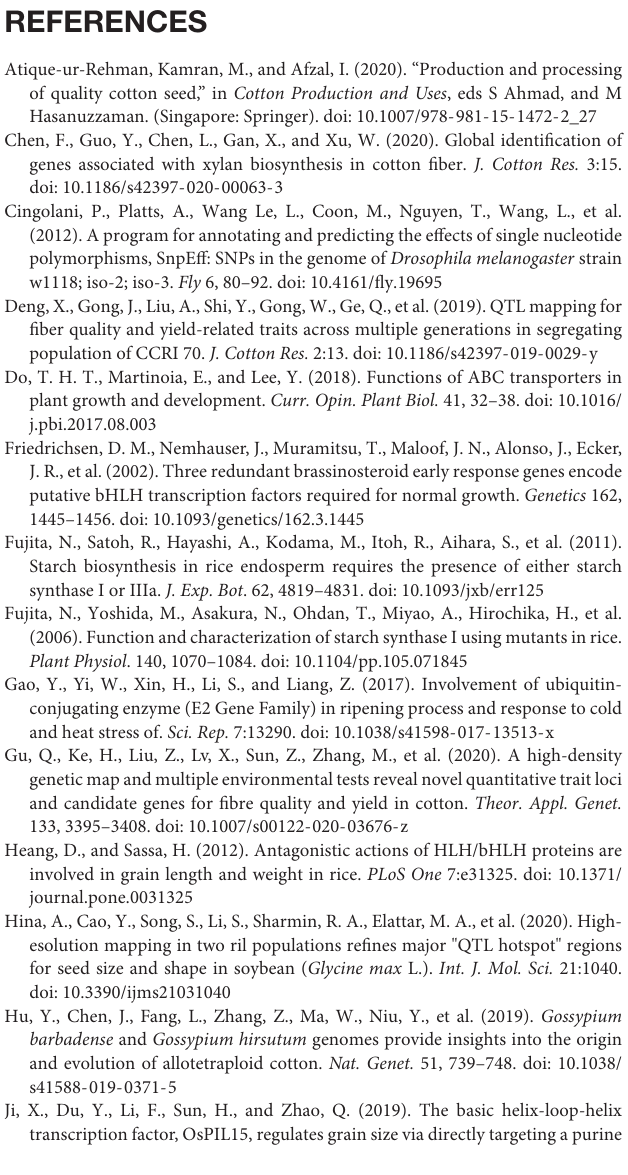
Supplementary Figure 1 | QTLs for seed size and shape-related traits under five environments and BLUP. The lines on the right side of the linkage groups indicate the QTL likelihood intervals. Map distances in centiMorgans are indicated on the left side of the linkage